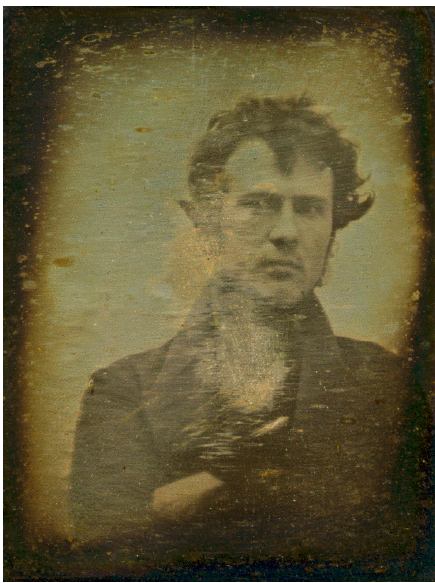
Figure 1. An American daguerreotype from 1839—amateur chemist and photography enthusiast Robert Cornelius in Philadelphia taking, as far as we know, the world’s first selfie. Image permission: this image is in the public domain. United States National Archives, Washington, DC, USA.